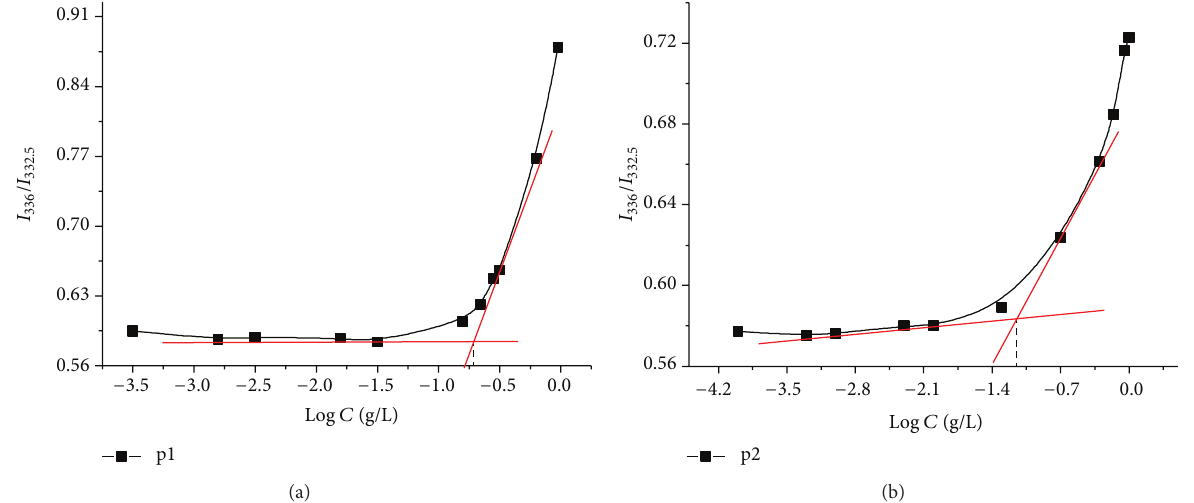
Figure2:Plotsofintensityratio( 𝐼 336 / 𝐼 332.5 )fromthepyreneexcitationspectraasafunctionofconcentrationsofp1(a)andp2(b),respectively. Pyrene concentration was fixed to be 6.0 × 10 −7 M, and the temperature is at 25 ∘